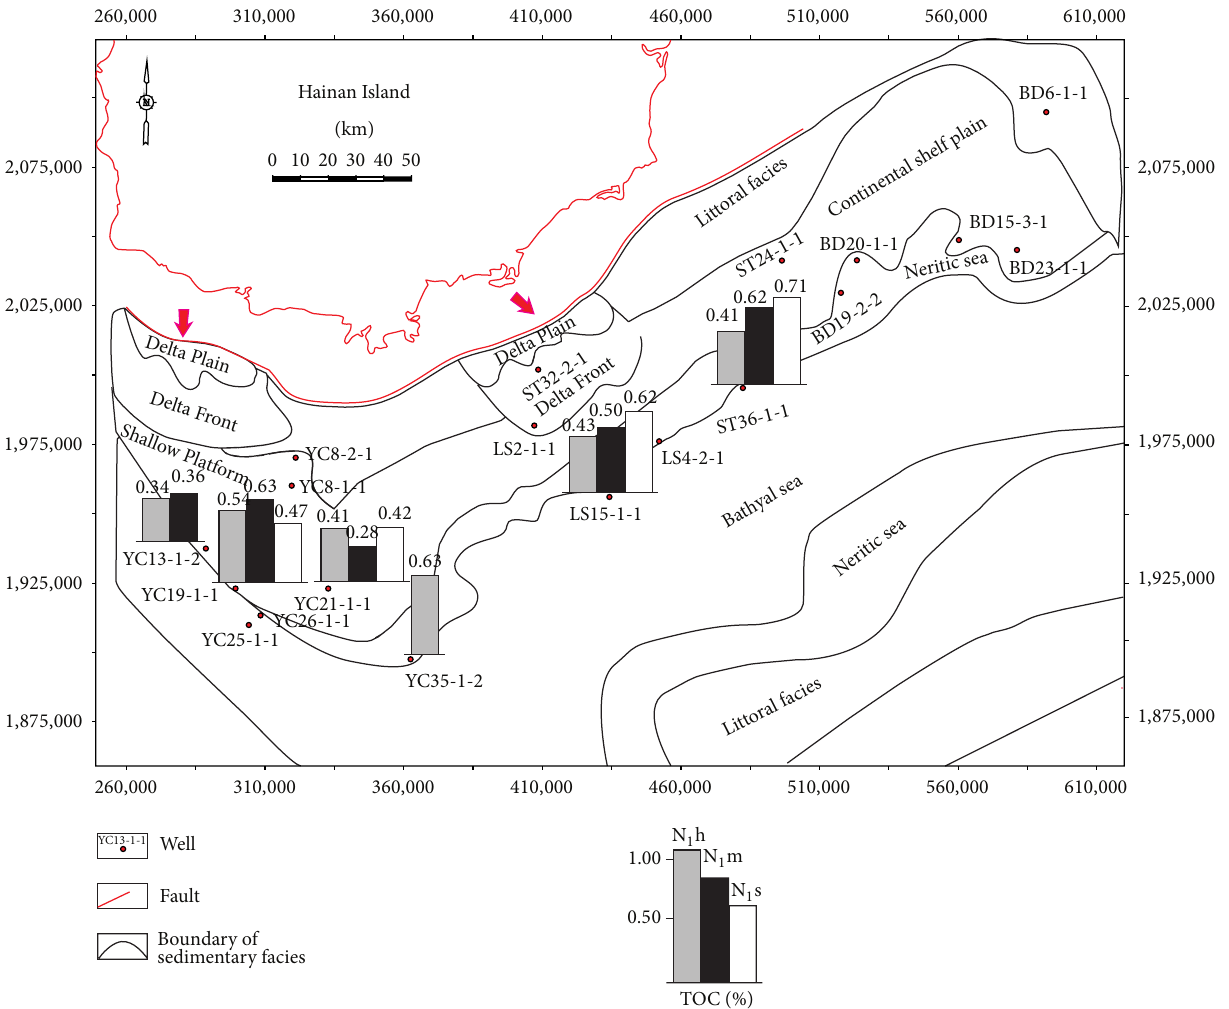
Figure 3: The distribution of TOC values of Miocene marine source rocks in some typical wells in the Qiongdongnan Basin.